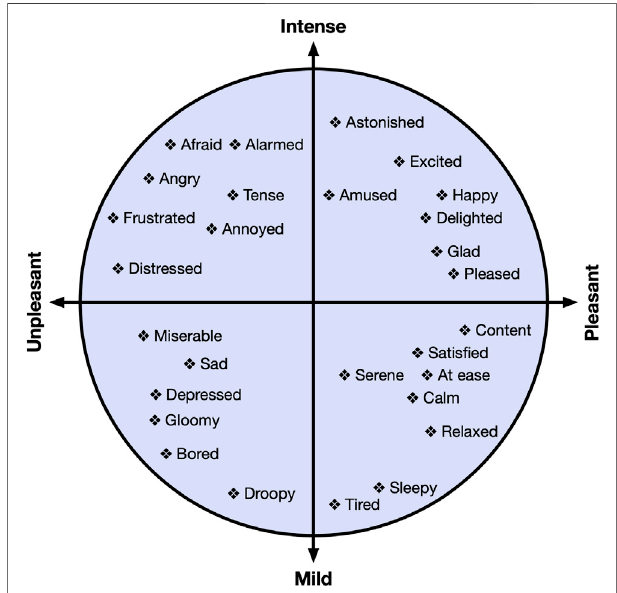
FIGURE 1 | The valence-arousal circumplex model of affect as de fi ned by Russell (Russell, 1980). The horizontal axis represents valence, while the vertical axis represents